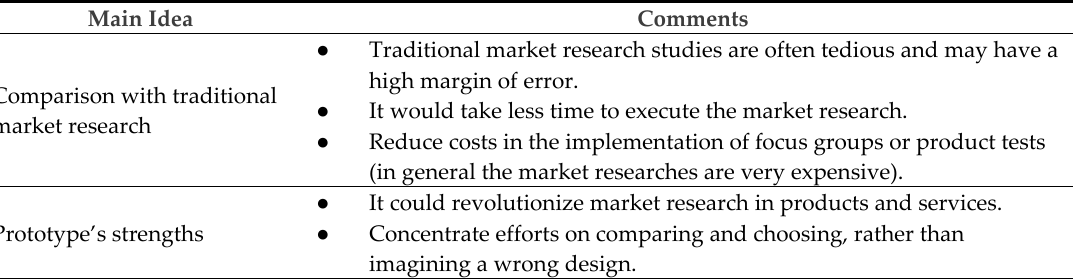
Table 5. Summary of participant